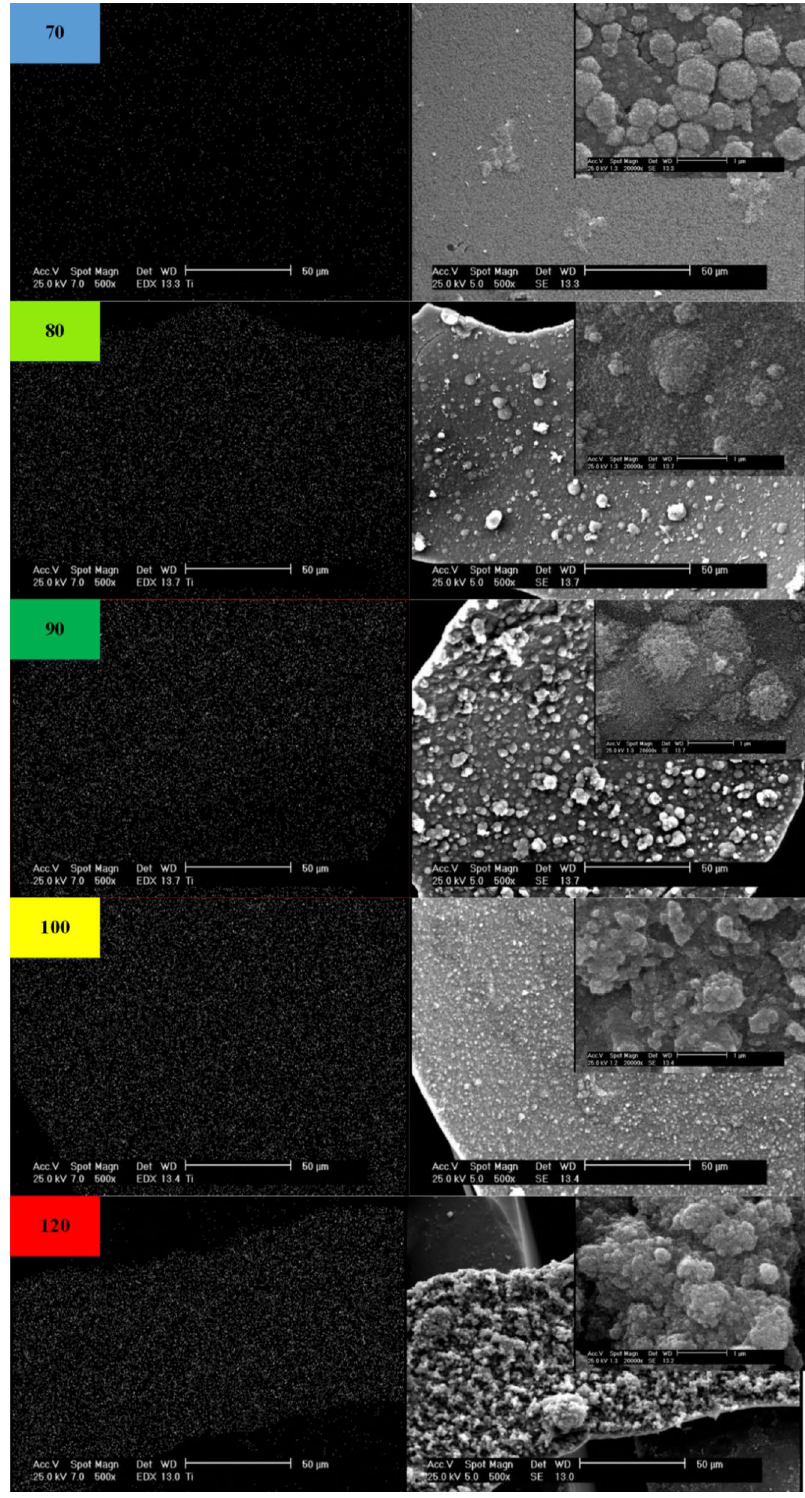
Figure 4. Surface morphology of TiO 2 and Ti Elemental mapping at several